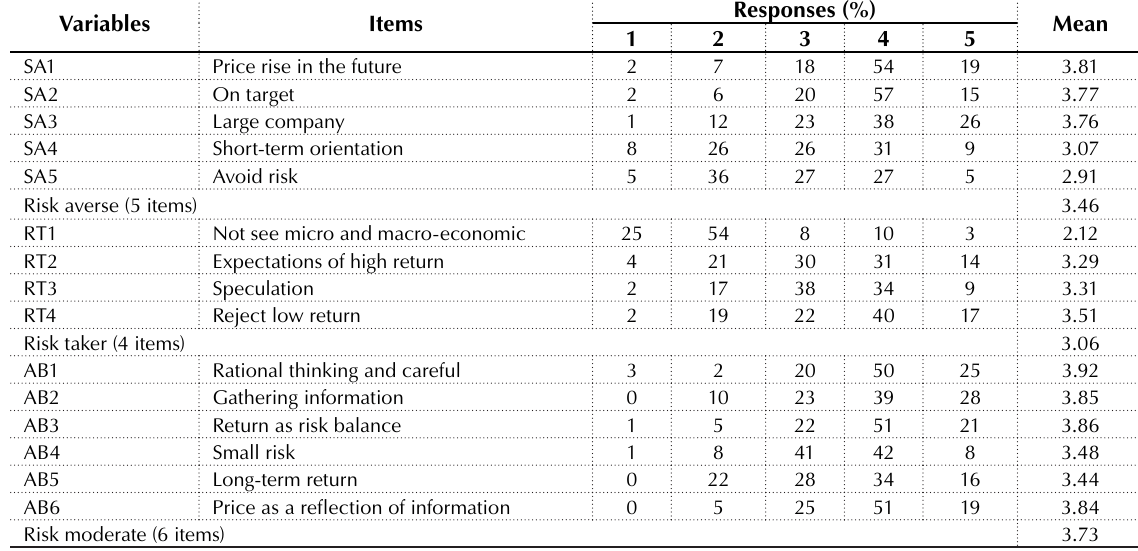
Table 4. Risk perception of investors